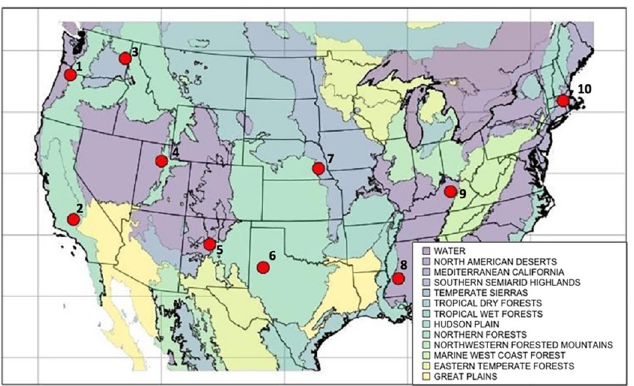
numbered red points. 1—Portland, OR, 2—Bakersfield, CA, 3—Spokane, WA, 4—Salt Lake City, UT, 5— Albuquerque, NM, 6—Lubbock, TX, 7—Lincoln, NE, 8—Jackson, MS, 9—Lexington, KY, and 10—Worcester, MA. Ecoregion GIS data was sourced from the US EPA—Ecoregion spatial database (https://www.epa.gov/eco-research/ ecoregions-north-america). Map was produced using the package ‘map’ in